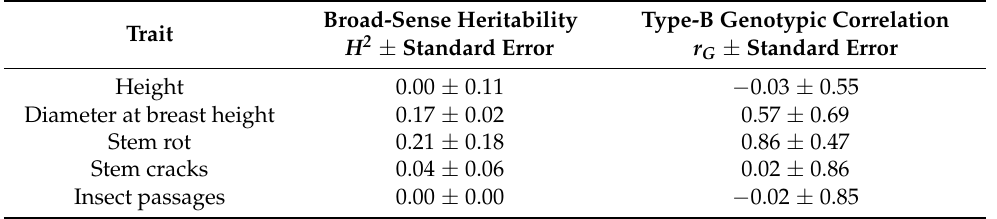
Table 2. Genetic parameters of the studied traits in the joint-site analyses of the hybrid aspen trials 640 and 699.